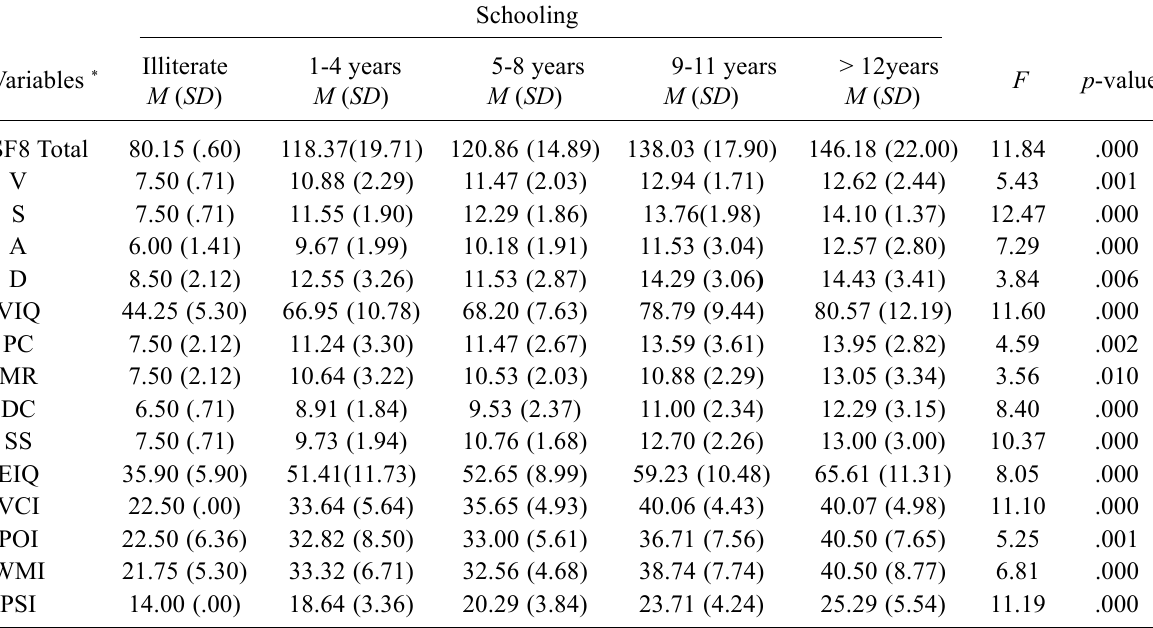
Cognitive Performance of Group 2 According to Schooling